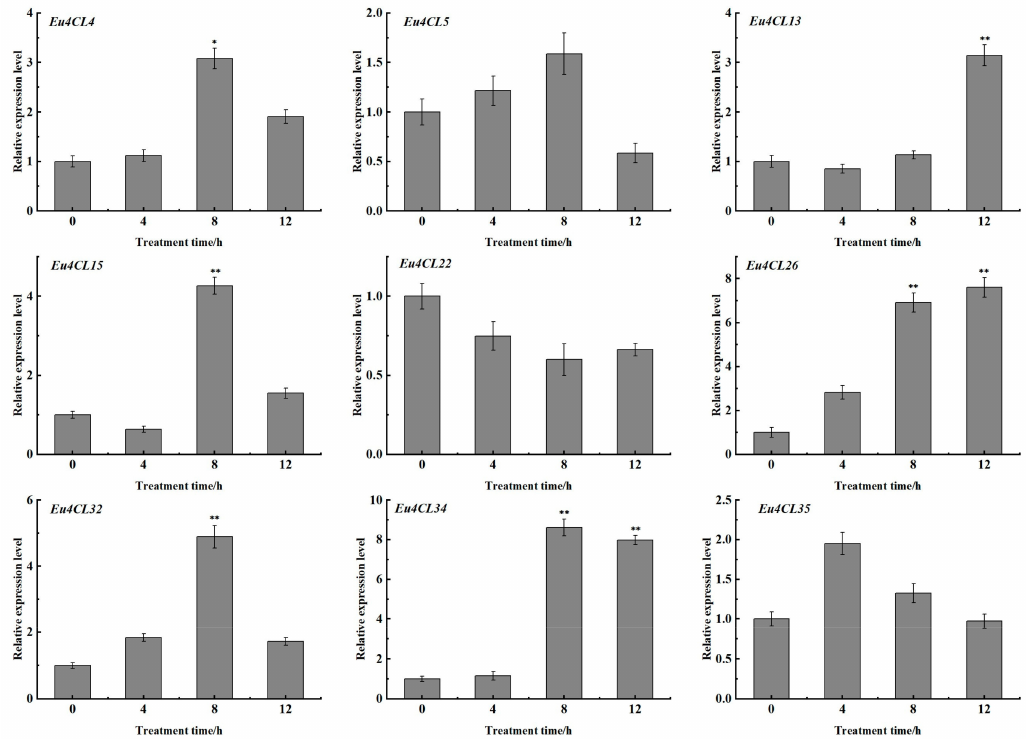
Figure 8. Expression profiles of selected Eu4CL genes under ethylene stress conditions. Error bars show the standard deviation of three biological replicates. * means significant correlation at a level of 0.05. ** means significant correlation at a level of